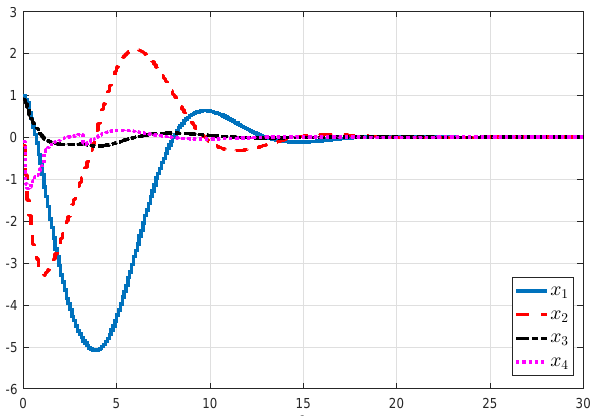
Figure 7. State trajectories in case 1.